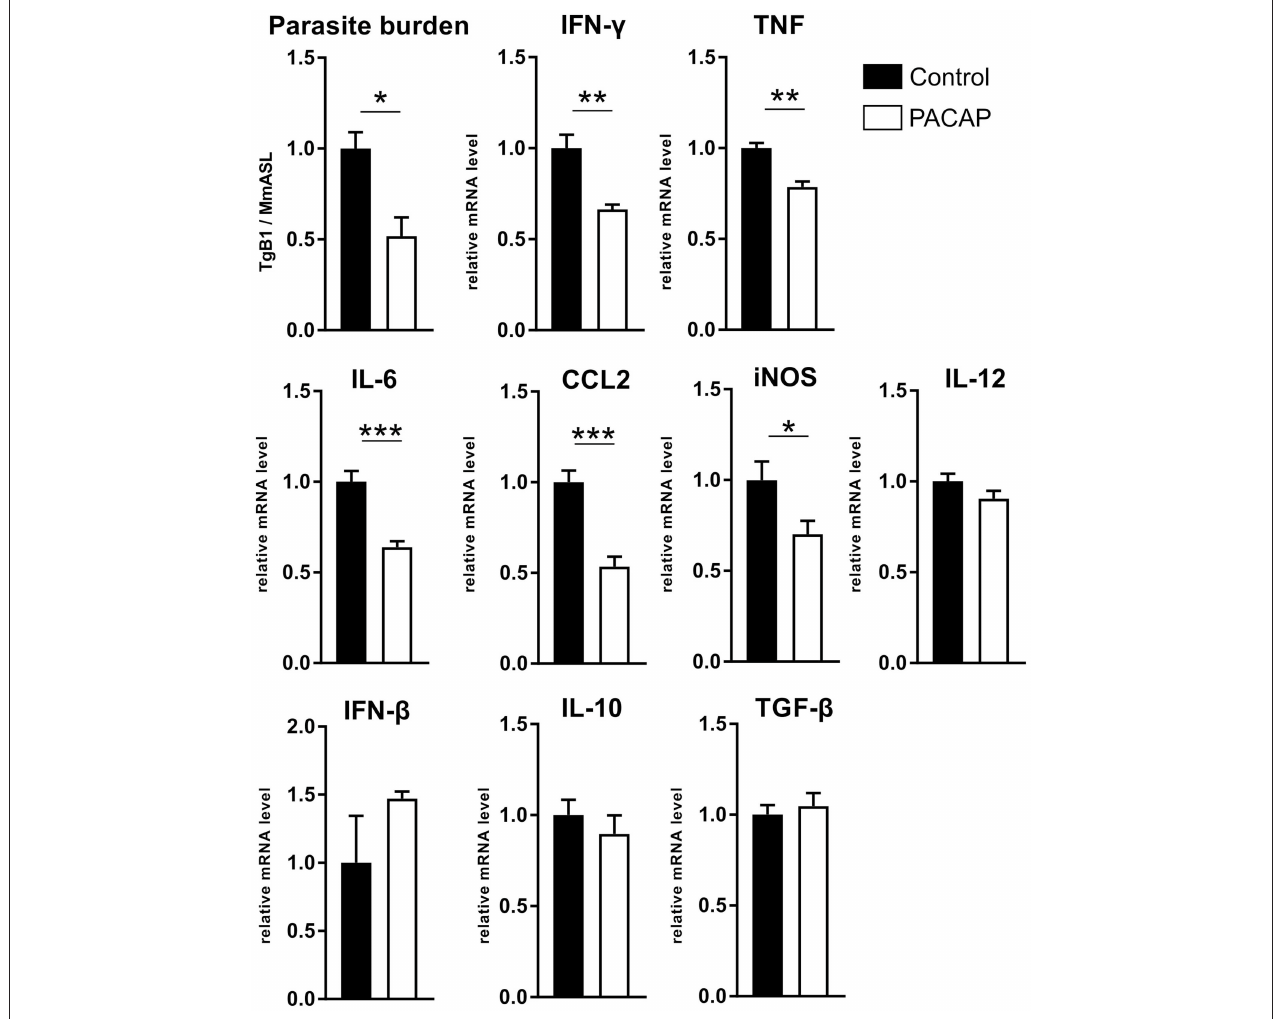
FIGURE 4 | PACAP alters parasite burden and inflammatory mediators. DNA and RNA were isolated from spleens of acutely infected mice and analyzed by qPCR and RT-qPCR. The parasite burden was determined based on the presence of B1 gene of T. gondii ( TgB1 ) normalized to the murine gene Asl . The gene expression levels of inflammatory mediators were determined by RT-qPCR using Hprt as reference gene. Data were further normalized to mean values of control group; Control (black bars) and PACAP-treated (white bars). Bar charts present results as mean ± SEM, n = 4. * p < 0.05, ** p < 0.01, *** p < 0.001 (two-tailed unpaired t